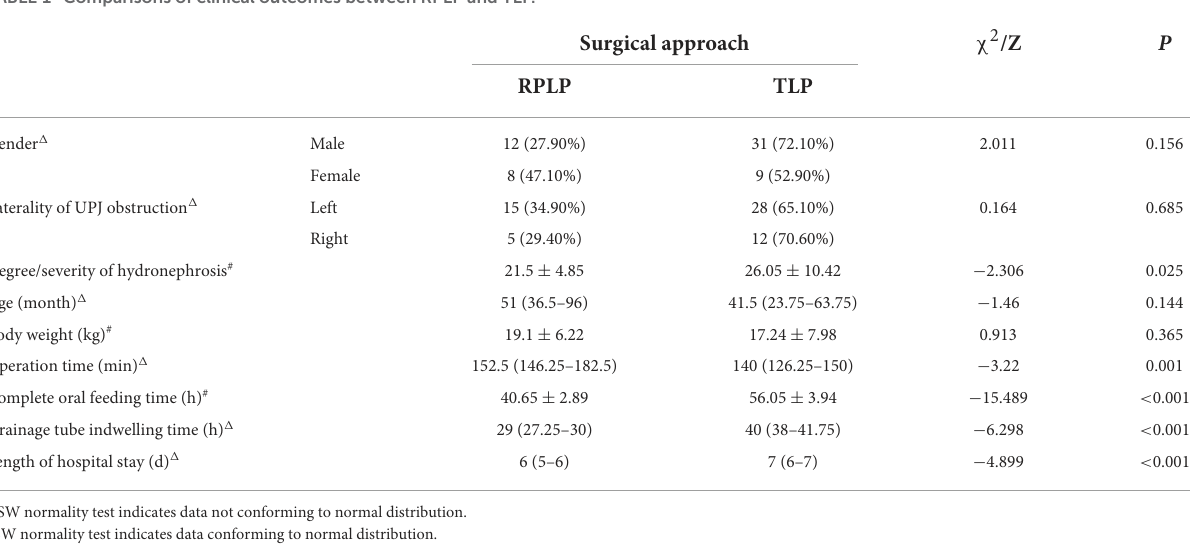
TABLE 1 Comparisons of clinical outcomes between RPLP and TLP.